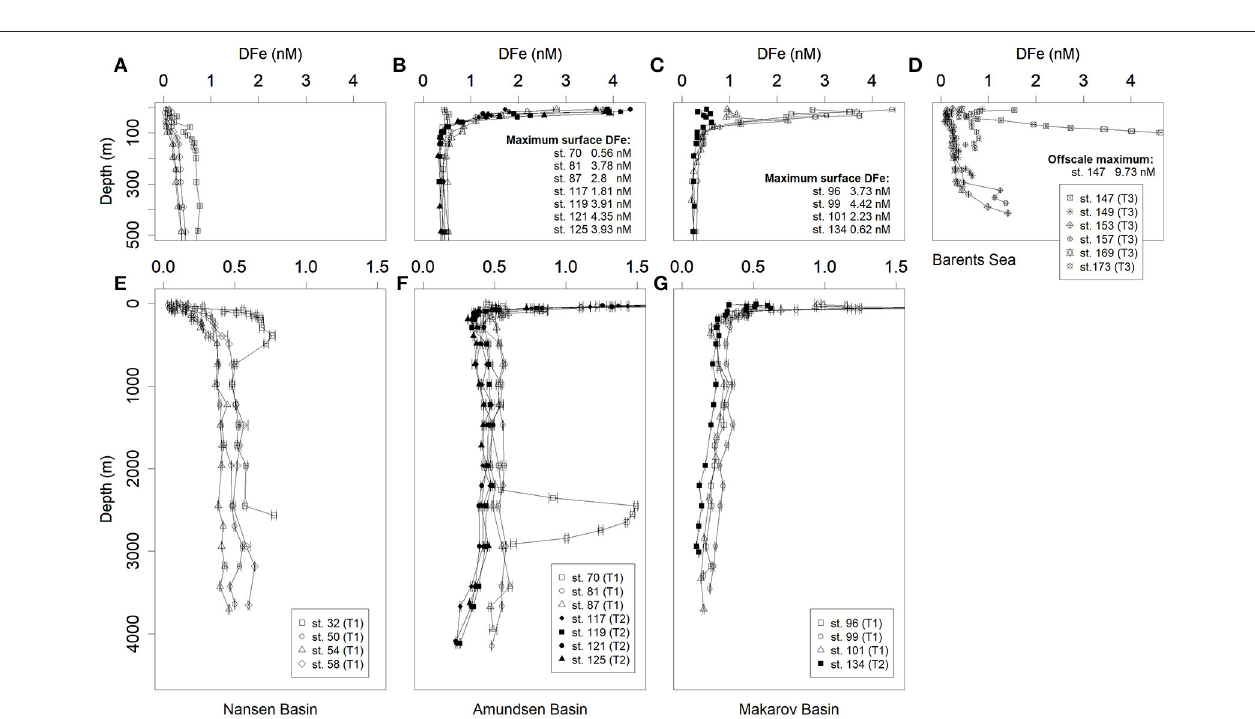
FIGURE 4 | Selected depth profiles of dissolved Fe concentrations (DFe) in nM. (A–C) Upper 500m of the Nansen, Amundsen and Makarov Basins, respectively; (D) Barents Sea (E–G) full depth profiles in the Nansen, Amundsen and Makarov Basins, respectively. Station numbers, basin names and transects numbers are indicated in the respective legends (see Figure 1 ). Surface maxima and offscale values are given in the figures. Symbols for Transect 1 are open, for Transect 2 filled and for Transect 3 crossed. Error bars indicate standard deviations ( N = 2 or 3). Most error bars fall inside of the symbols.